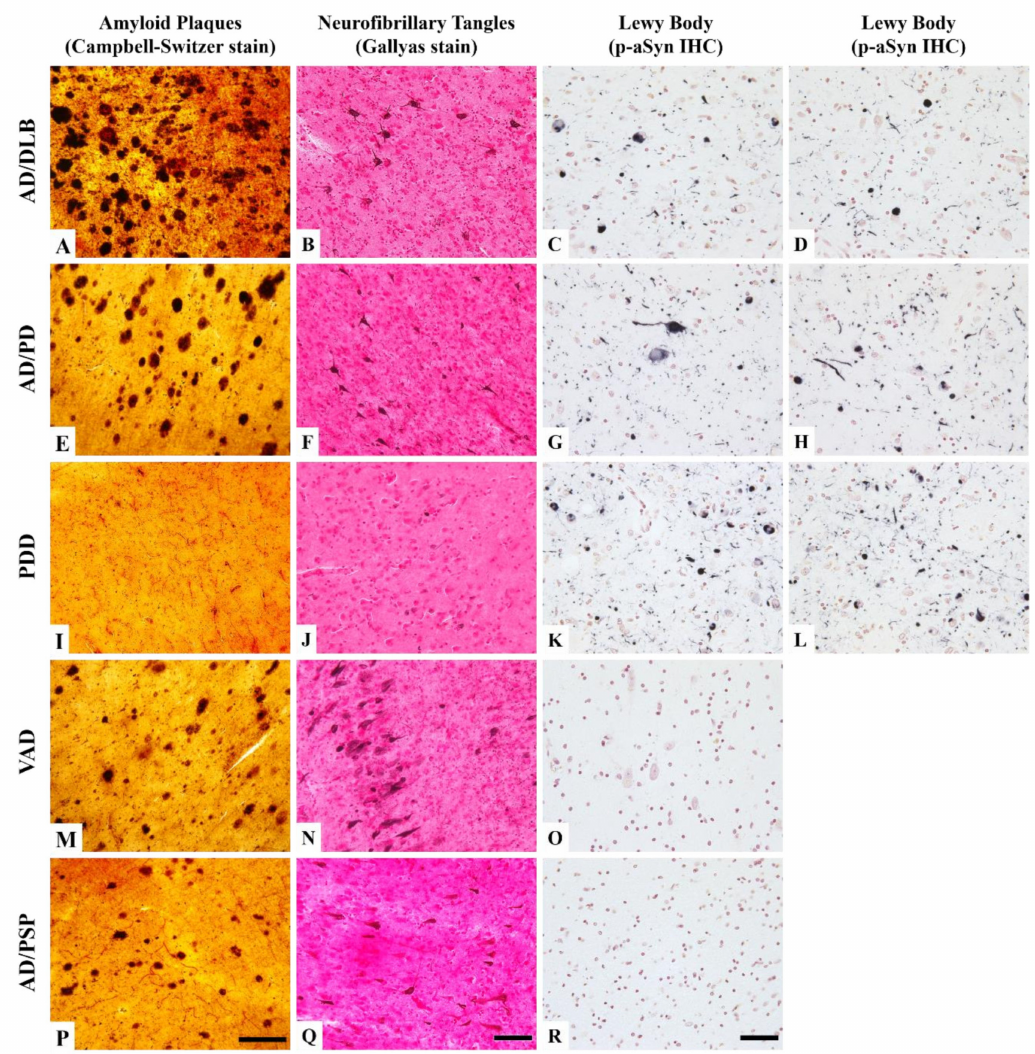
Figure 2. Representative staining profiles of various neuropathological diagnoses in Campbell-Switzer and Gallyas staining and immunohistochemical staining of p- α Syn. The photo images were taken from a case with AD / DLB diagnosis ( A – D ), a case with AD / PD diagnosis ( E – H ), a case with PDD diagnosis ( I – L ), a case with VAD ( M – O ), and a case with AD / PSP ( P – R ). ( A , E , I , M , P ): Amyloid plaques in dark brown color in various abundance are shown in the temporal cortical area. ( B , F , J , N , Q ): Neurofibrillary tangles in medium brown are shown at various densities in the entorhinal cortex. ( C , D , G , H , K , L , O , R ): Lewy body and Lewy neurites in black are shown in neutral red counter stained amygdala. Scale bars: Campbell-Switzer stain, 250 µ m; Gallyas stain, 150 µ m; p- α Syn immunohistochemical stain, 50 µ m. Abbreviation: AD, Alzheimer’s disease; DLB, dementia of Lewy body; PD, Parkinson’s disease; PDD, Parkinson’s disease with dementia; VAD, vascular Alzheimer’s dementia; p- α Syn, phosphorylated α -Synuclein; PSP, progressive supranuclear